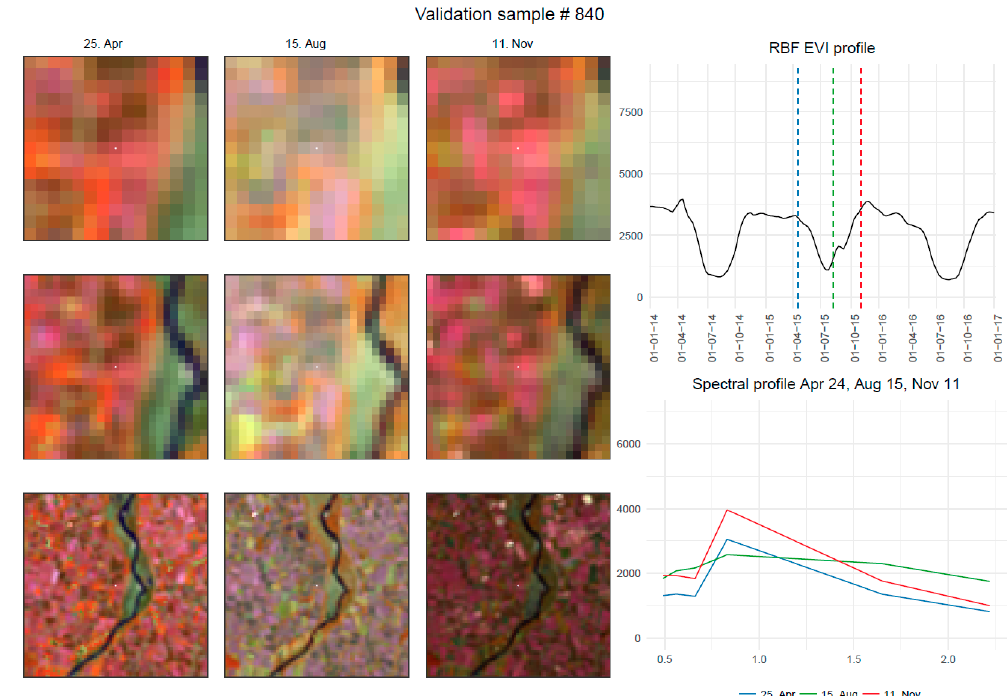
Figure A5. Validation pixel protocol for class greenhouse.